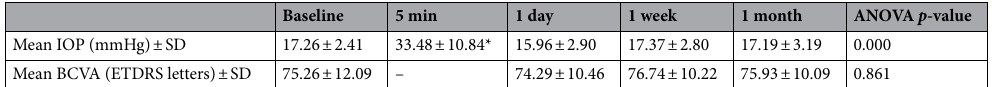
Table 2. Comparison of mean IOP and mean BCVA. IVI intravitreal injections, ANOVA analysis of variance, IOP intraocular pressure, mmHg millimeters of mercury, BCVA best corrected visual acuity, ETDRS